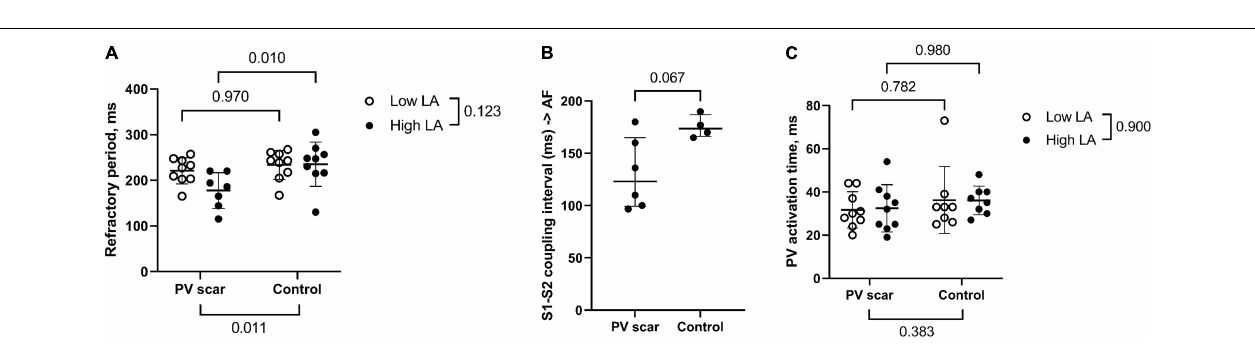
FIGURE 6 | Diastolic stimulation threshold. (A) In high LA pressure, the diastolic PV stimulation threshold was higher in hearts with PV scar compared with control hearts ( n = 9 vs. n = 9, respectively, a two-way repeated measures ANOVA). (B) The heterogeneity in PV excitability, defined as the range in stimulation threshold in both PVs, was larger in hearts with PV scar than in controls ( n = 9 vs. n = 8, respectively, mixed-effects linear model). Of note, 1 control heart had only 1 induction attempt, and therefore 1 threshold measurement, in high LA pressure preventing calculation of a range in excitability.